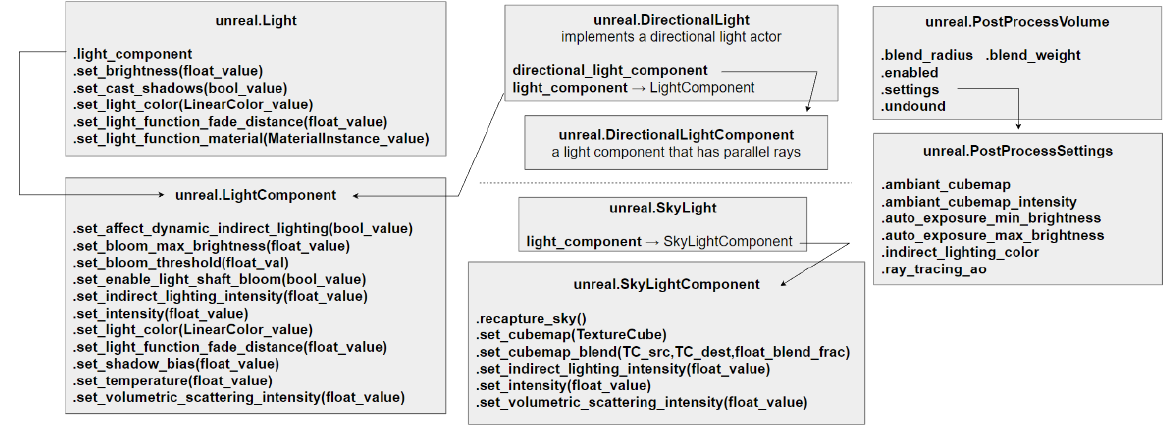
Figure 17. Unreal documentation: Unreal classes for